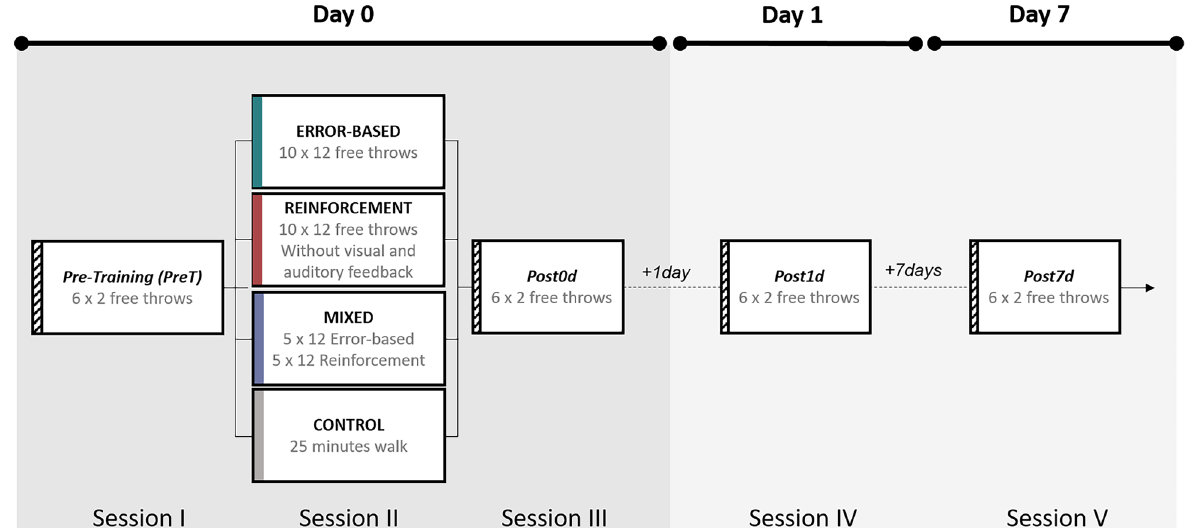
Figure 1. Experimental procedure. All participants carried out 6 blocks of 2 free throws in the Pre-Training test (PreT). For the training session, they were divided into four groups, and all, except those of the control group, carried out 120 free throws (i.e., 10 blocks of 12 free throws with 30 s of rest between blocks). During training, the error-based group received full sensory feedback, the reinforcement group received only binary feedback (success or failure), the mixed group received full sensory feedback followed by binary feedback, and the control group walked for 25 min, which corresponded to the training period of the other groups. Immediately (Post0d), one day (post1d), and seven days (post7d) after training, all participants carry out 12 free throws as in the